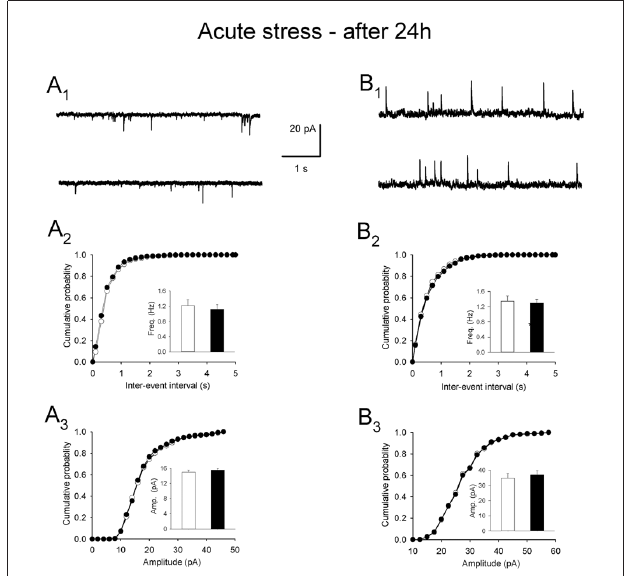
FIGURE 4 | Miniature postsynaptic currents after acute restraint stress followed by a 24-h delay before recordings. (A 1 ) Representative raw recording of mEPSCs in control conditions ( upper trace ) and after restraint ( lower trace ). (A 2 ,A 3 ) Cumulative probability plots of inter-event interval and amplitude distributions in control ( white circles/bars ) and stress ( black circles/bars ) conditions. Insets : comparison of the average values ( ± SEM). (B 1 ) Representative recording of mIPSCs in control ( upper trace ) and after restraint ( lower trace ). (B 2 ,B 3 ) Cumulative probability plots comparing inter-event interval and amplitude distributions in control ( white circles/bars ) and stress ( black circles/bars ) conditions. Insets : comparison of the average values ±